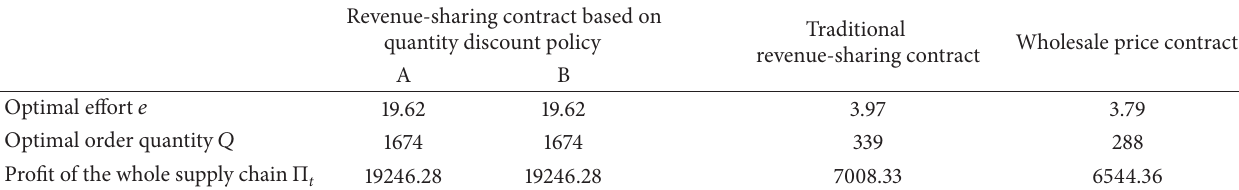
Table 2: The parameters of supply chain in different modes with only manufacturer bearing effort